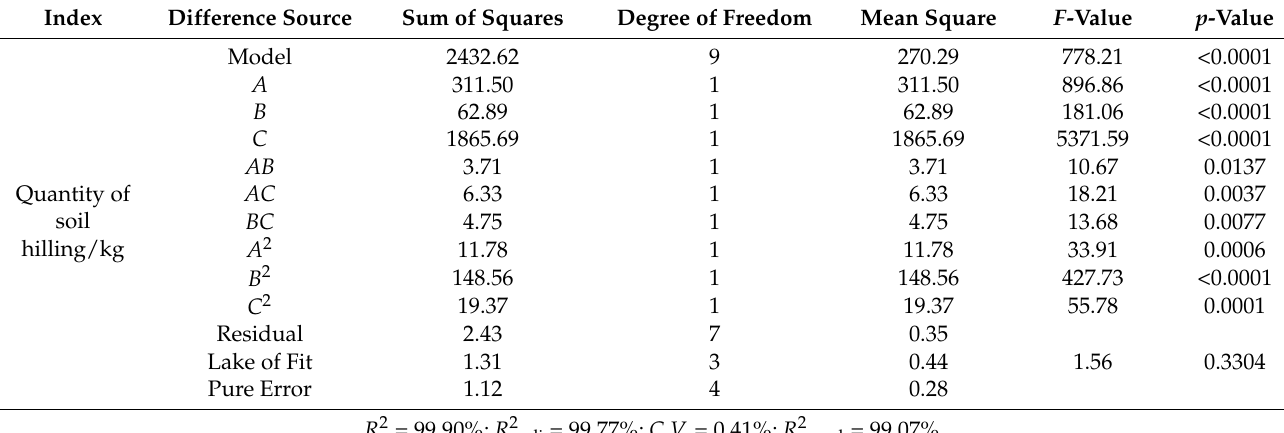
Table 4. Variance analysis of regression models.